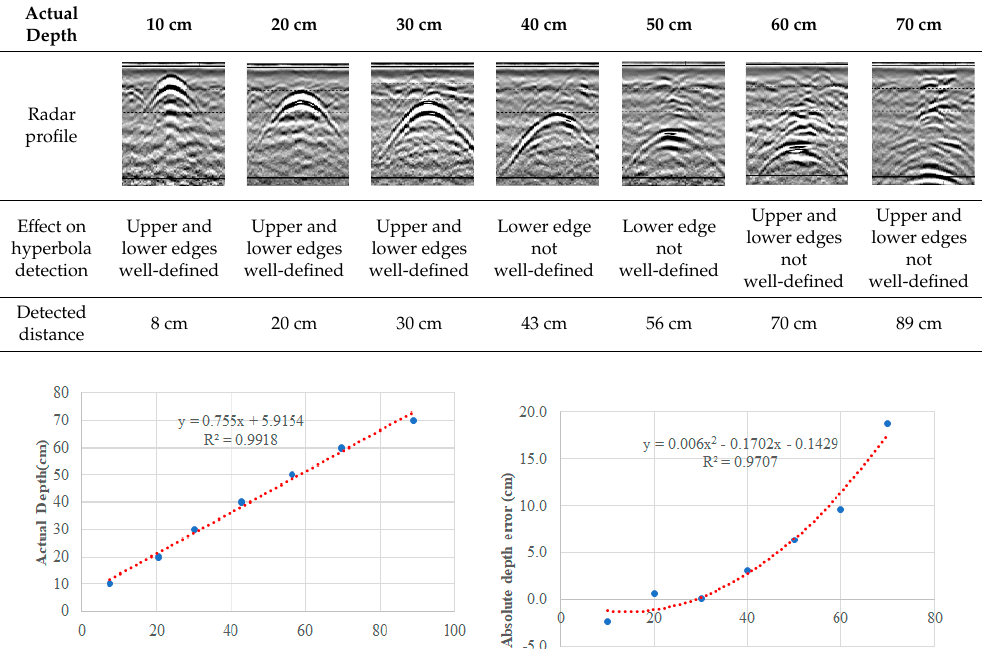
Table 5. Radar profiles of a root buried at different depths.